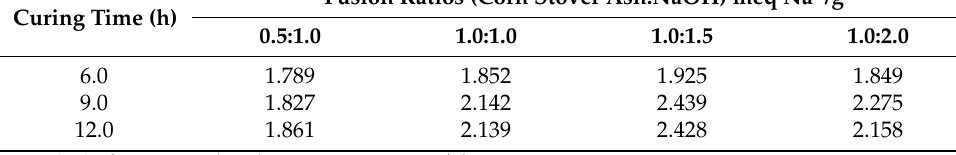
Table 3. Cation exchange capacities of zeolite A synthesized using various curing times and fusion ratios. Fusion Ratios (Corn Stover Ash:NaOH) meq Na + /g Curing Time (h) 0.5:1.0 1.0:1.0 1.0:1.5 1.0:2.0 6.0 1.789 1.852 1.925 1.849 9.0